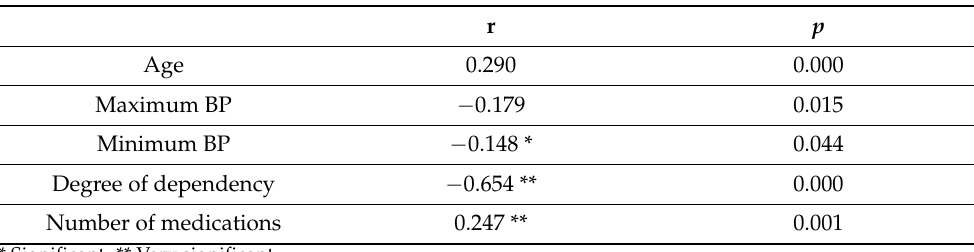
Table 6. Relationship between fall risk and age, maximum blood pressure, minimum blood pressure, degree of dependency and number of